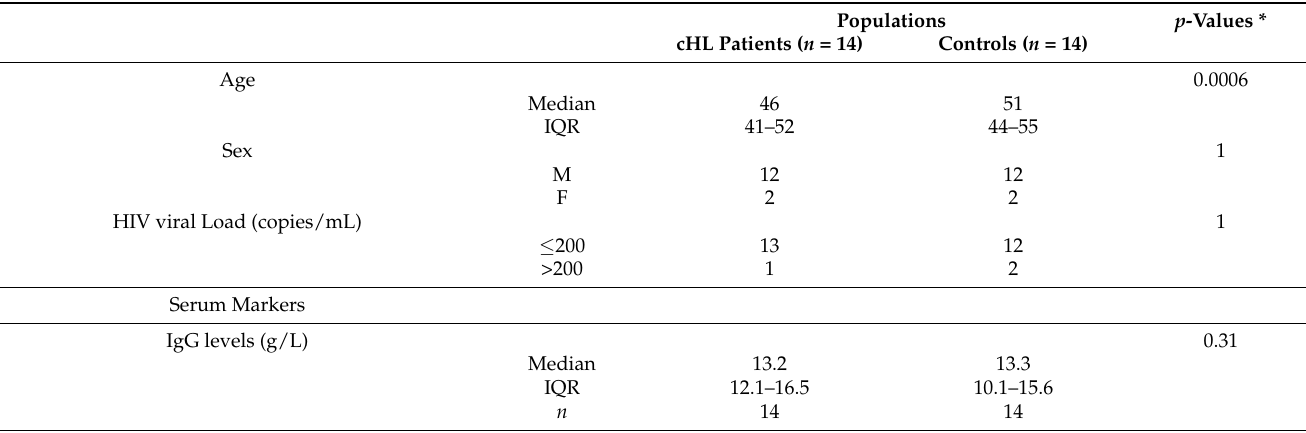
Table 2. Characteristics of HIV-cHL patients with matched controls at cHL